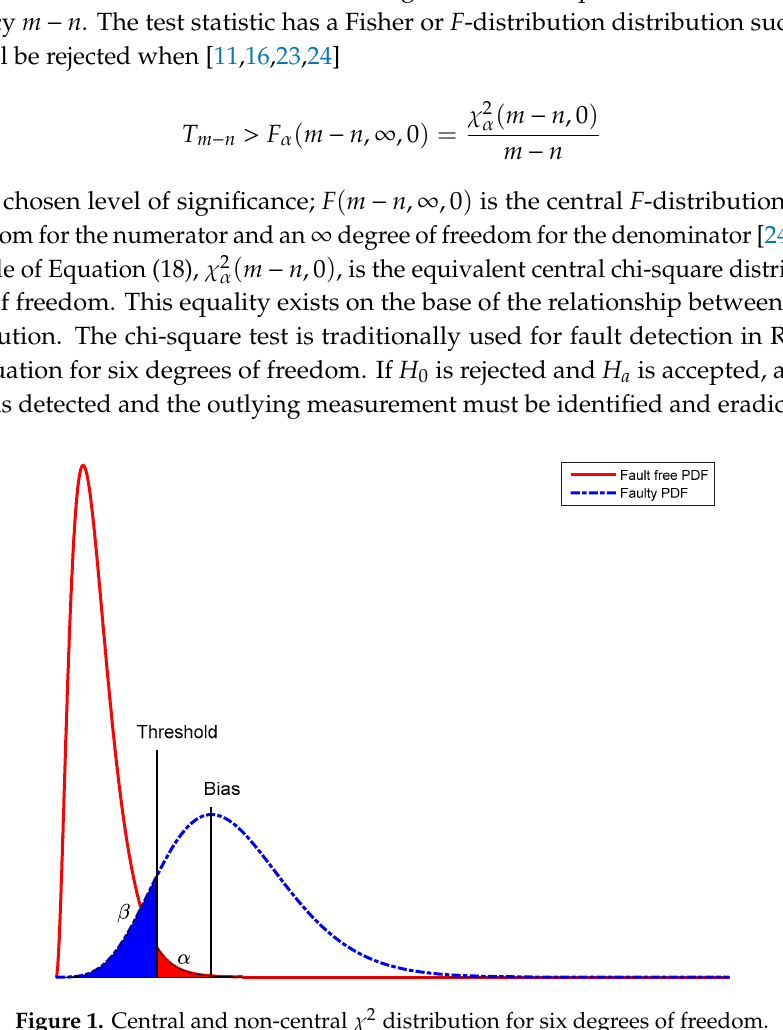
Figure 1. Central and non-central χ 2 distribution for six degrees of freedom.